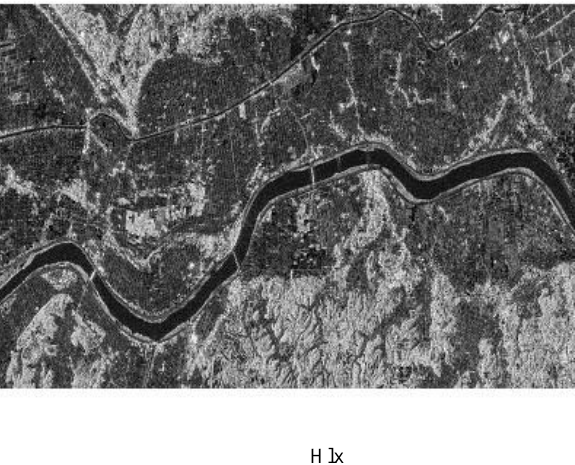
Figure 5. Yamaguchi’s 4-Component Decomposition The Wishhart H/A/Alpha classification method is a kind of unsupervised classification methods. (Figure 6.)